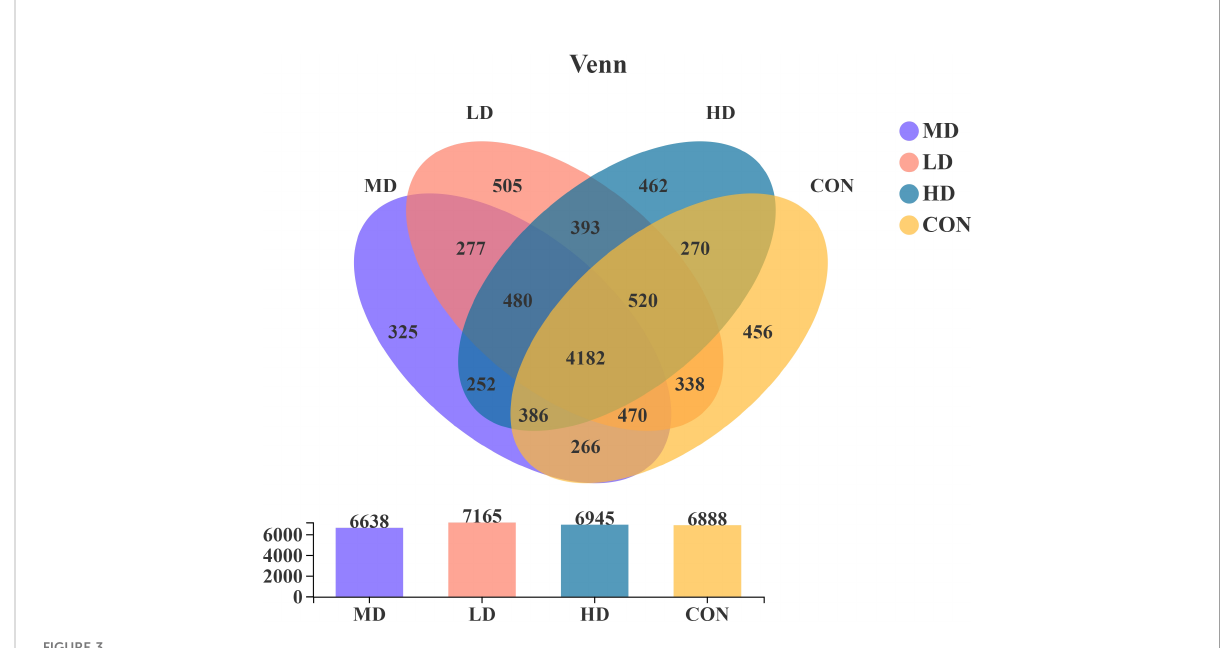
FIGURE 3 Venn diagram analysis of the community composition over all